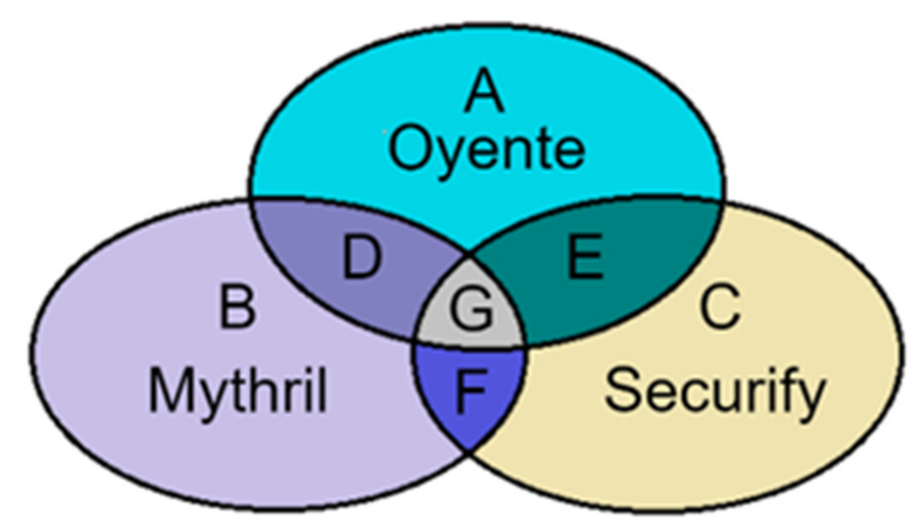
Figure 3. Guidelines for labeling vulnerabilities.